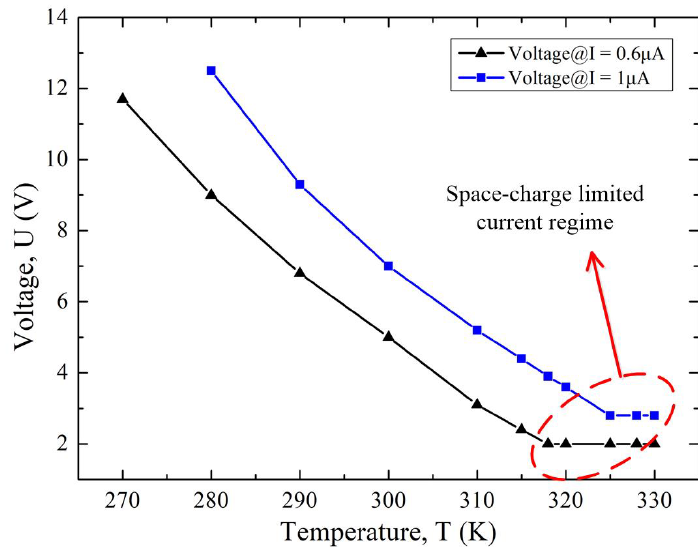
Figure 4. Simulated temperature response characteristics of the diode.